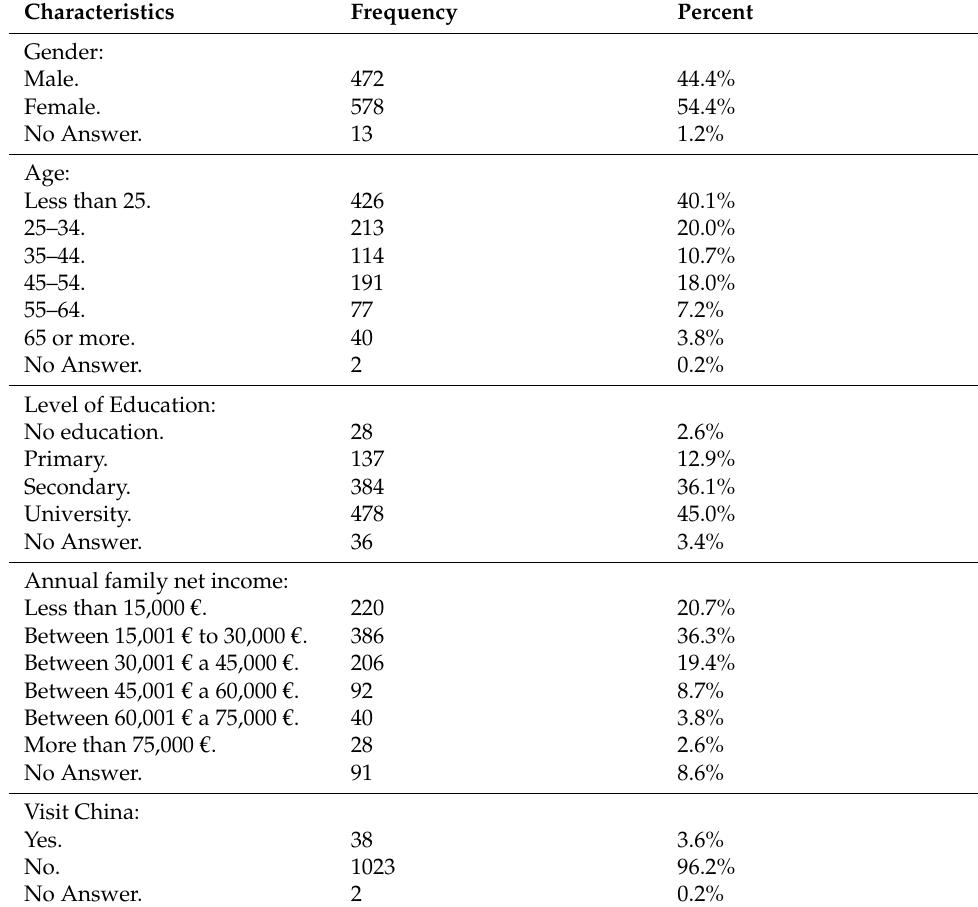
Table 1. Demographic profile of the sample